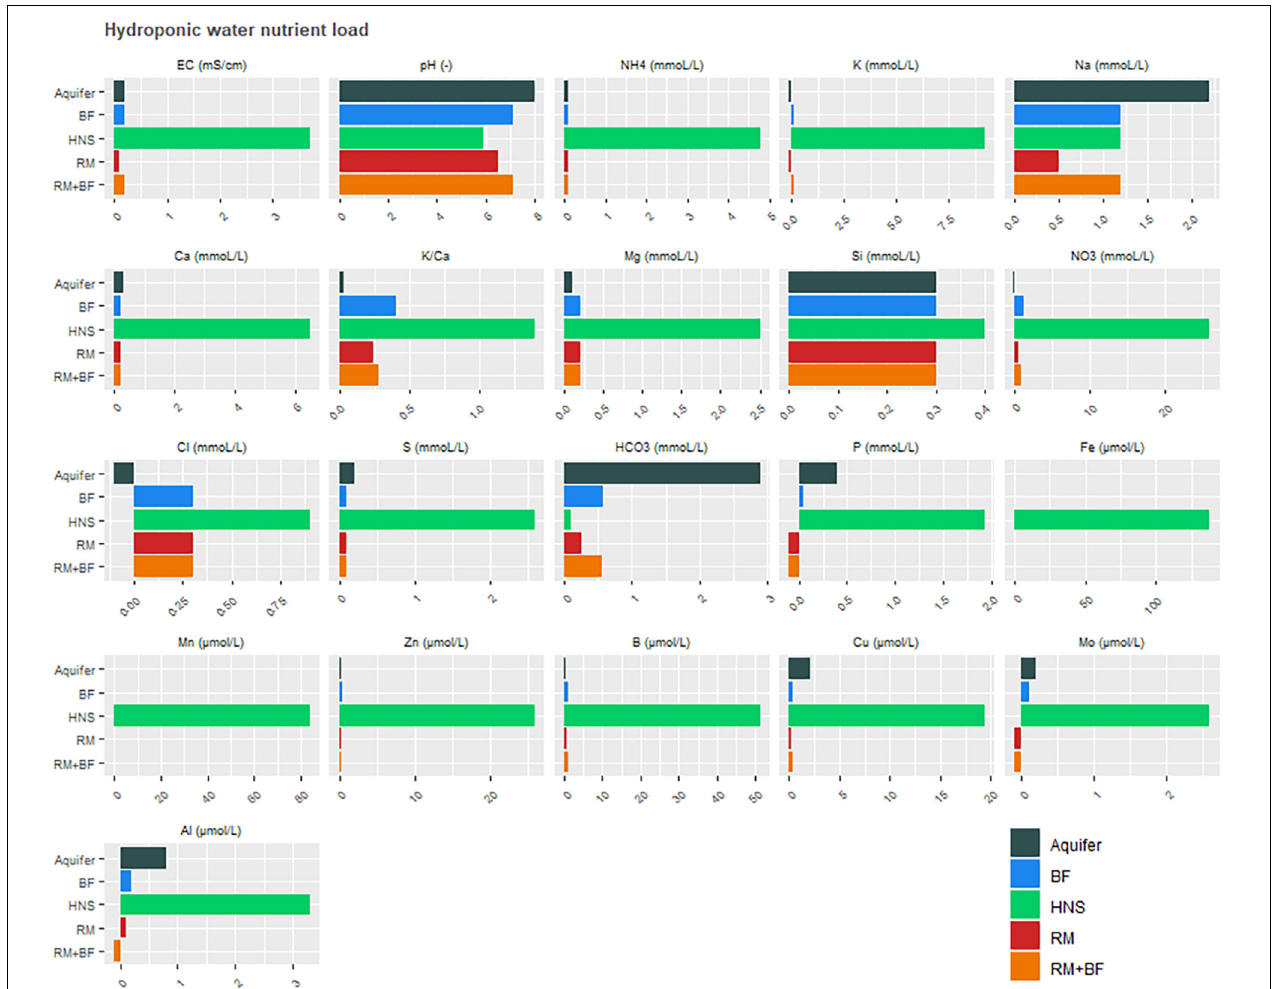
FIGURE 5 | Nutrient loads across greenhouse nutrient solutions, all measurements were taken 1 week prior to